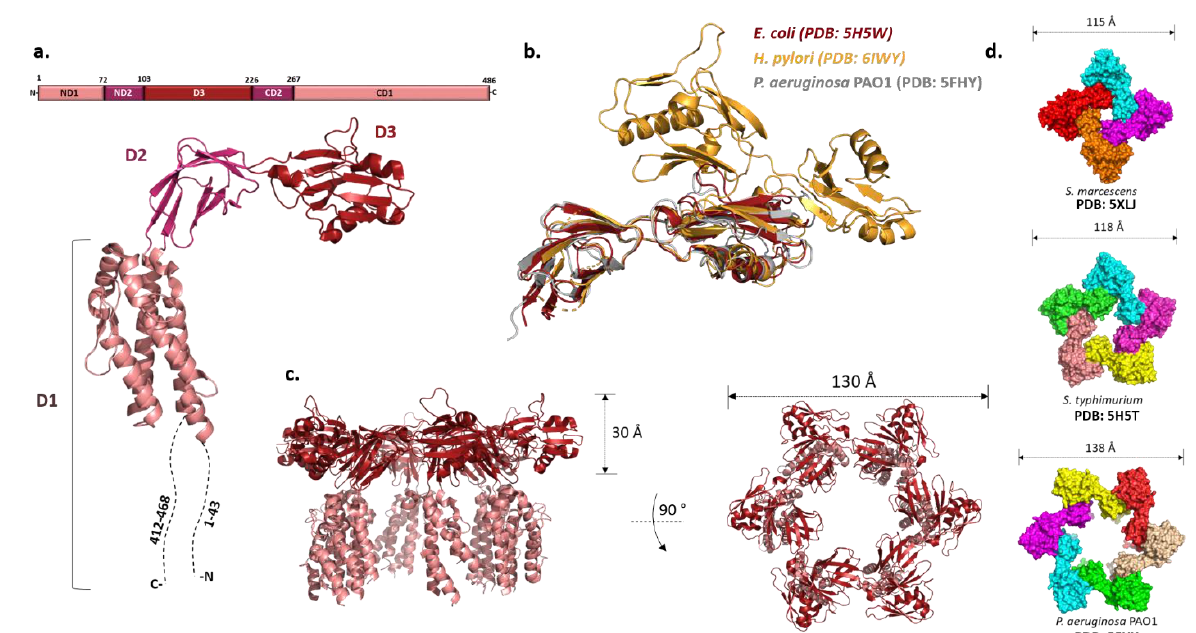
Figure 3. FliD and the filament cap. ( a ) Structure of FliD from E. coli shows three domains (D1–D3) (PDB: 5H5V). The N- and C-termini are highly flexible and could not be resolved. ( b ) Structural alignment of FliD molecules from different species show high structural homology of D2 and D3 domains. FliD from H. pylori has two additional domains, D4 and D5. ( c ) Crystal structure of the filament cap from E. coli showing a hexameric structure. Domains D2 and D3 form the head region, while D1 (incomplete) forms the flexible leg region; ( d ) Oligomeric states of the crystallized FliD caps differ across